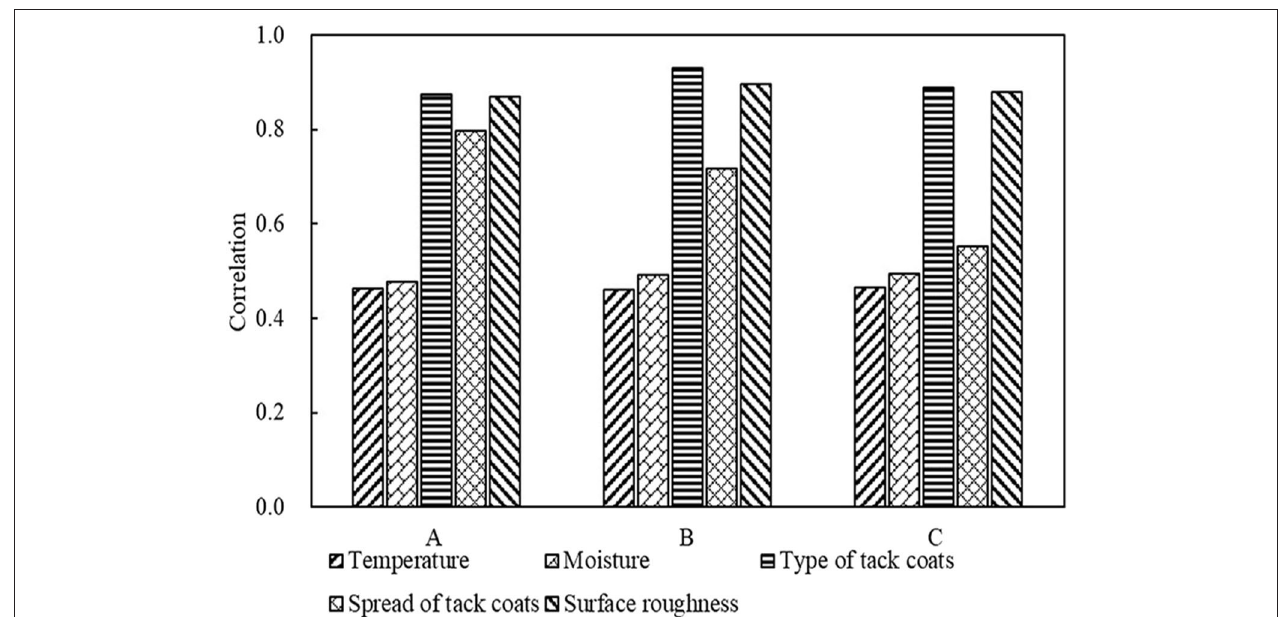
FIGURE 13 | The gray correlation